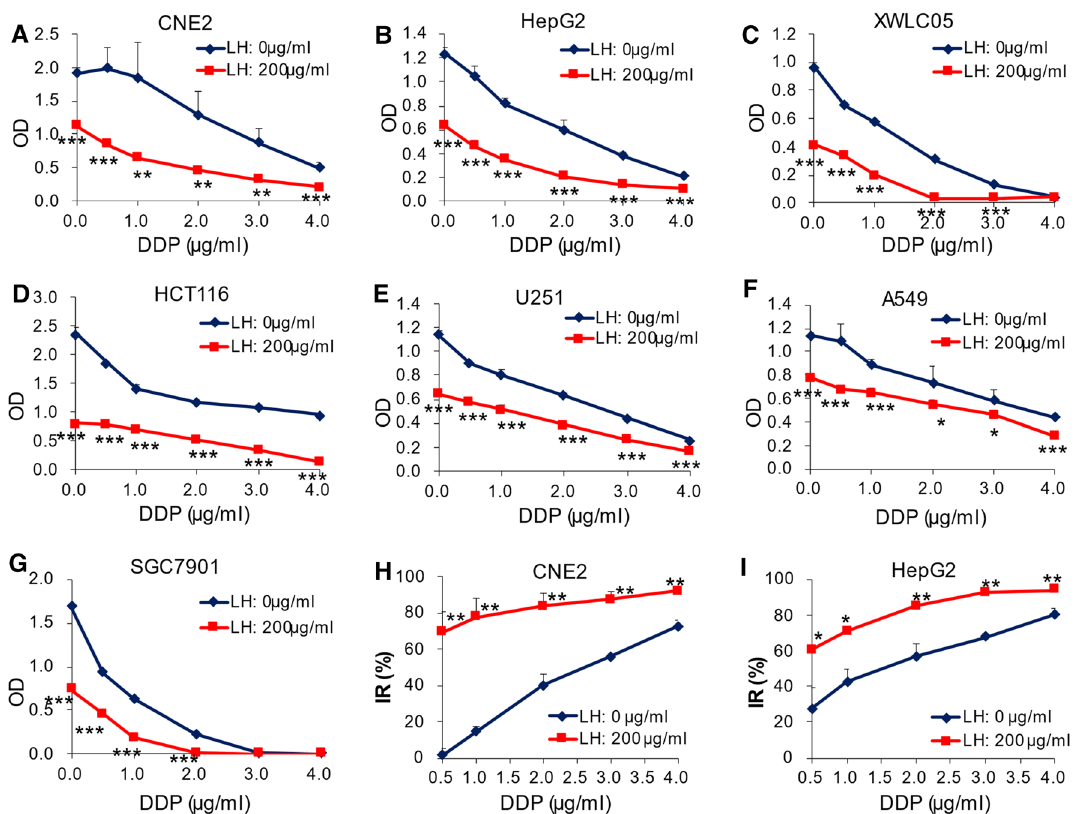
Fig.1 Combination of levofloxacin and cisplatin enhances cytotoxicity in cancer cells. A–G Comparation of OD between LH + DDP group and DDP group at each DDP concentration. CNE2 cells ( A ), HepG2 cells ( B ), XWLC05 cells ( C ), HCT116 cells ( D ), U251 cells ( E ), A549 cells ( F ), SGC7901 cells ( G ). H IR comparison between LH + DDP group and DDP group at each DDP concentration in CNE2 cells. I IR comparison between LH + DDP group and DDP group at each DDP concentration in HepG2 cells. Data is expressed as mean ± standard deviation (SD), A-G is from 6 replicates in one experiment, H and I is from 3 independent experiments. * p < 0.05, ** p < 0.01 and *** p < 0.001 Table 1 Q values in different cancer cell lines by the evaluation of drug